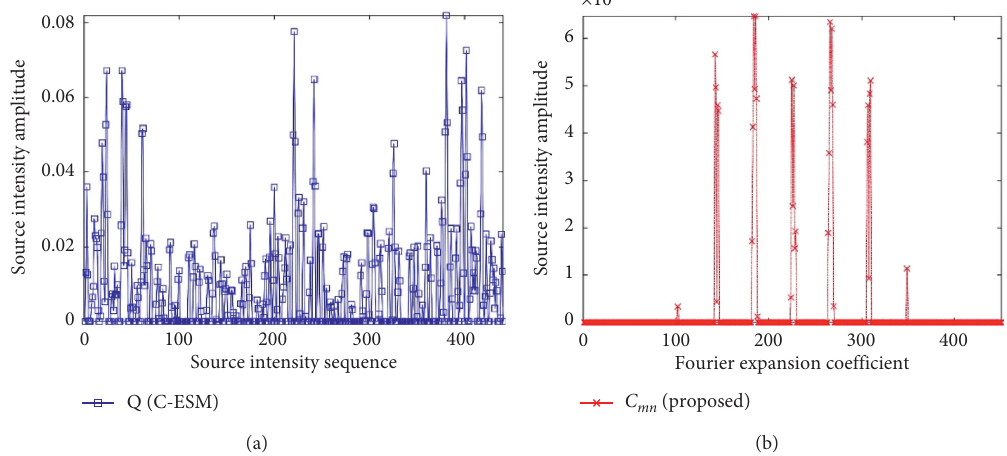
Figure 2: Amplitude obtained using the compressive equivalent source method and the method with a sampling rate of 1000Hz. (a) Compressive equivalent source method. (b) Method of this